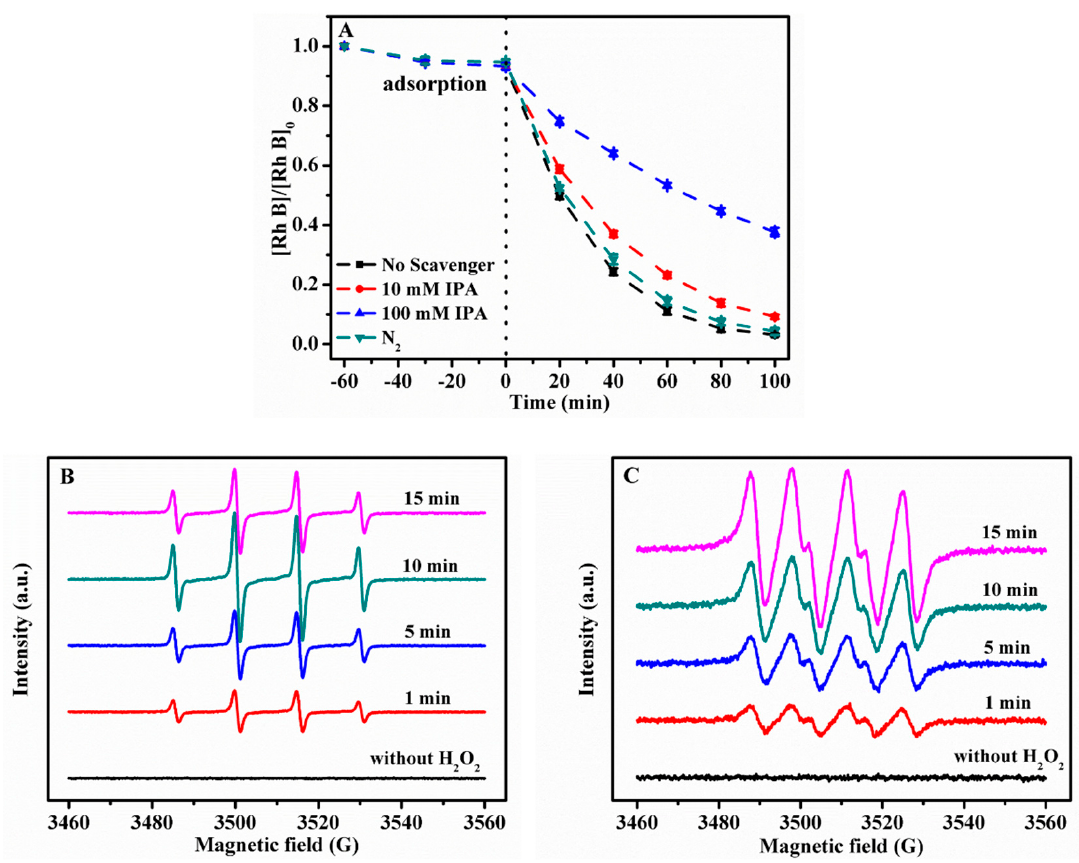
Figure 14. ( A ) [Rh B]/[Rh B] 0 as a function of time in the presence of different concentrations of IPA and N 2 bubbling. ESR spectra of ( B ) DMPO-HO · adducts in aqueous solution and ( C ) DMPO-O 2 · − and N 2 bubbling. ESR spectra of ( B ) DMPO-HO· adducts in aqueous solution and ( C ) DMPO-O 2 · − adducts in methanol solution recorded with the Cu / Al 2 O 3 / CN adducts in methanol solution recorded with the Cu/Al 2 O 3 /CN composite.